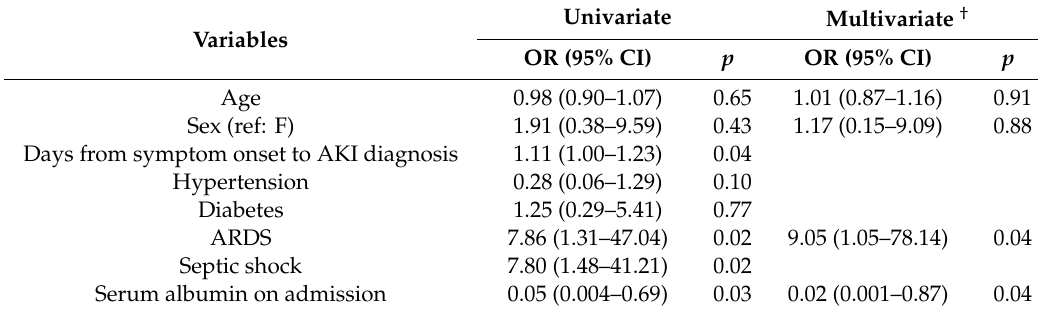
Table 6. Risk factors for severe AKI among AKI patients in the logistic regression